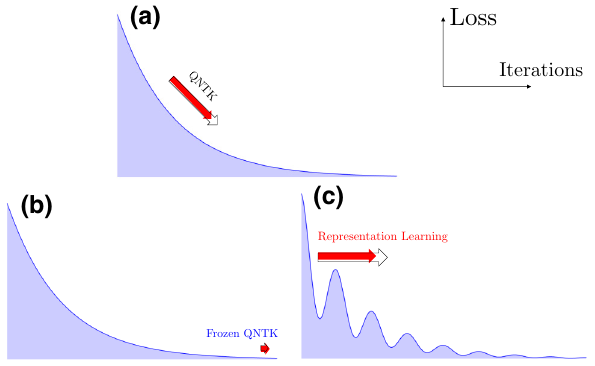
FIG. 1. An illustration of the QNTK theory. (a) The QNTK characterizes the gradient-descent dynamics in the variational quantum circuit. The quantum state modifies according to the QNTK prediction. (b) Around the end of the training, the QNTK is frozen and almost a constant. (c) The gradient-descent dynam- ics could be highly nonlinear, and the QNTK is running during gradient descent, which is a property of representation learning.